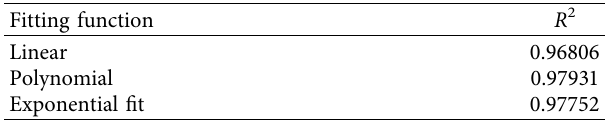
Figure 8: Relationship between W and moisture content. CF Table 4: Fitting functions and their related R 2 for determining the best relation between W and moisture CF